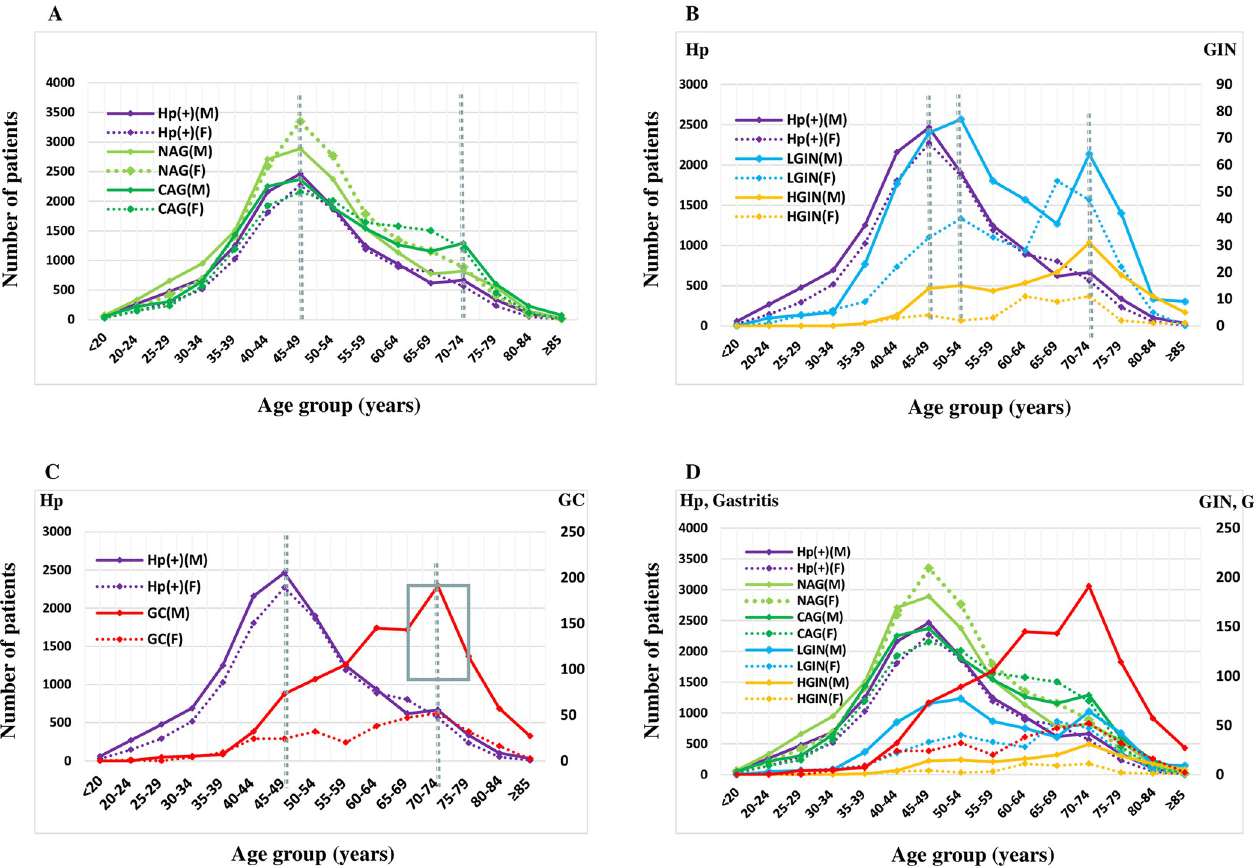
Fig 2. Age distributions of patients in Hp infection and gastric diseases detected by conventional gastroscopy. (A) age distributions of patients in gastritis and Hp infection; (B) age distributions of patients in GIN and Hp infection; (C) age distributions of patients in GC and Hp infection; (D) age distributions of patients in Hp infection, gastritis, GIN and GC; For males, The time spans (TS) from the first peak of Hp infection to the first peaks of gastric diseases varied dramatically depending on different gastric diseases: the overlapping peaks (0–5 years) for patients with gastritis; 5–10 years for patients with GINs, 15–20 years for patients with gastric cancer, respectively. It was interesting to note that the longest TS was 25–30 years from the first peak of Hp infection to the second peak of gastric cancer. The time spans (TS) from the ages of Hp infection patients at the second detection peak to the ages of gastritis, GIN, and GC patients at the second detection peak are 0–5 years. For females, The time spans (TS) from the first peak of Hp infection to the first peaks of gastric diseases varied dramatically depending on different gastric diseases: the overlapping peaks (0–5 years) for patients with gastritis; 5–10 years for patients with LGIN, 15–20 years for patients with HGIN, 5–10 years for patients with gastric cancer, respectively. It was interesting to note that the longest TS was 25–30 years from the first peak of Hp infection to the second peak of gastric cancer. However, there were also differences in time intervals from Hp infection at the second detection peak to the second peak of gastritis (0–5 years), GIN (5–10 years), and GC (5–10 years),